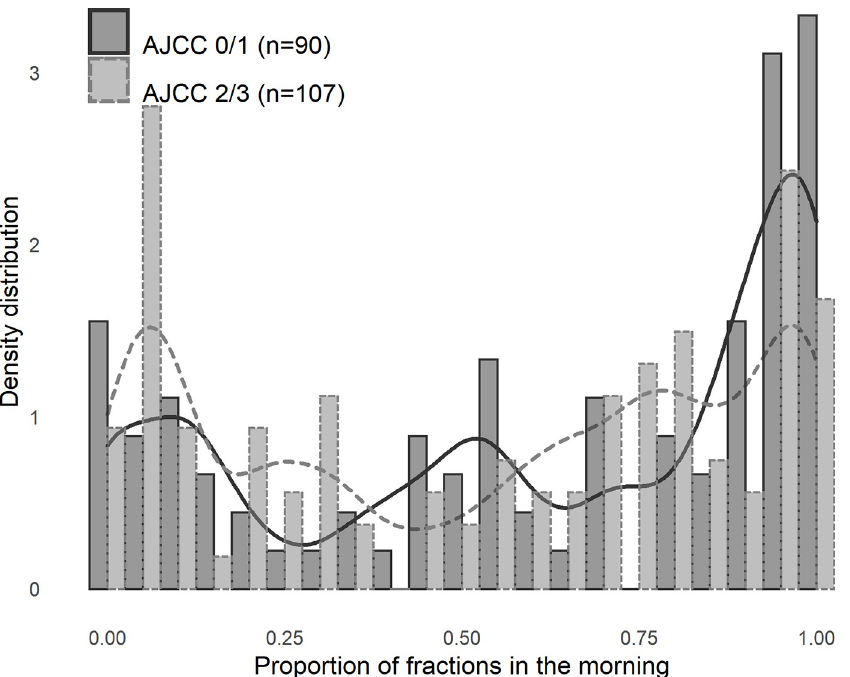
Fig 2. Proportion of morning radiotherapy treatments by tumour regression grade. Histogram, in bins of 0.05 (5%), illustrating distribution of proportion of radiotherapy fractions in the morning (before 1230h) per patient, stratified by AJCC regression grade, overlaid by a kernel density plot. No significant between group differences, but trend towards a bigger proportion of morning treatments for patients with AJCC 0/1 regression (p = 0.077).